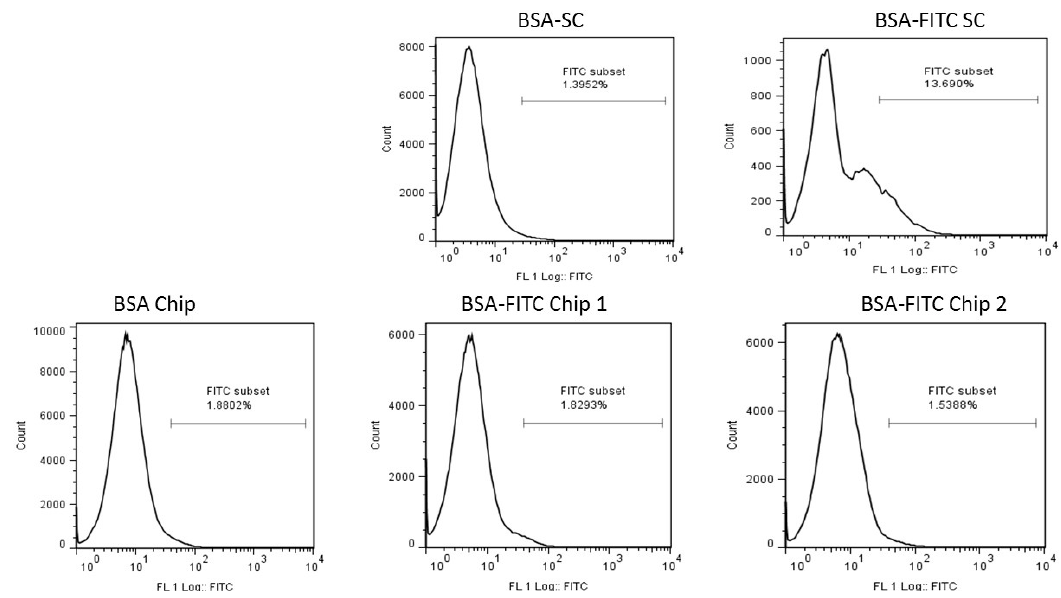
Figure 5. Antigen (BSA-FITC) migration to lymph nodes either subcutaneously or through the application of nano-rod devices (Chips 1 and 2). BSA alone, either injected subcutaneously (BSA-SC) or adsorbed on the nano-rod device (BSA Chip) acted as negative controls. After 24 h, BSA-FITC injected subcutaneously (BSA-FITC SC, positive control) showed dendritic cells’ migration to the lymph nodes, while BSA-FITC delivered by the two nano-rod devices (BSA-FITC Chip 1 and BSA-FITC Chip 2) showed negligible migration.